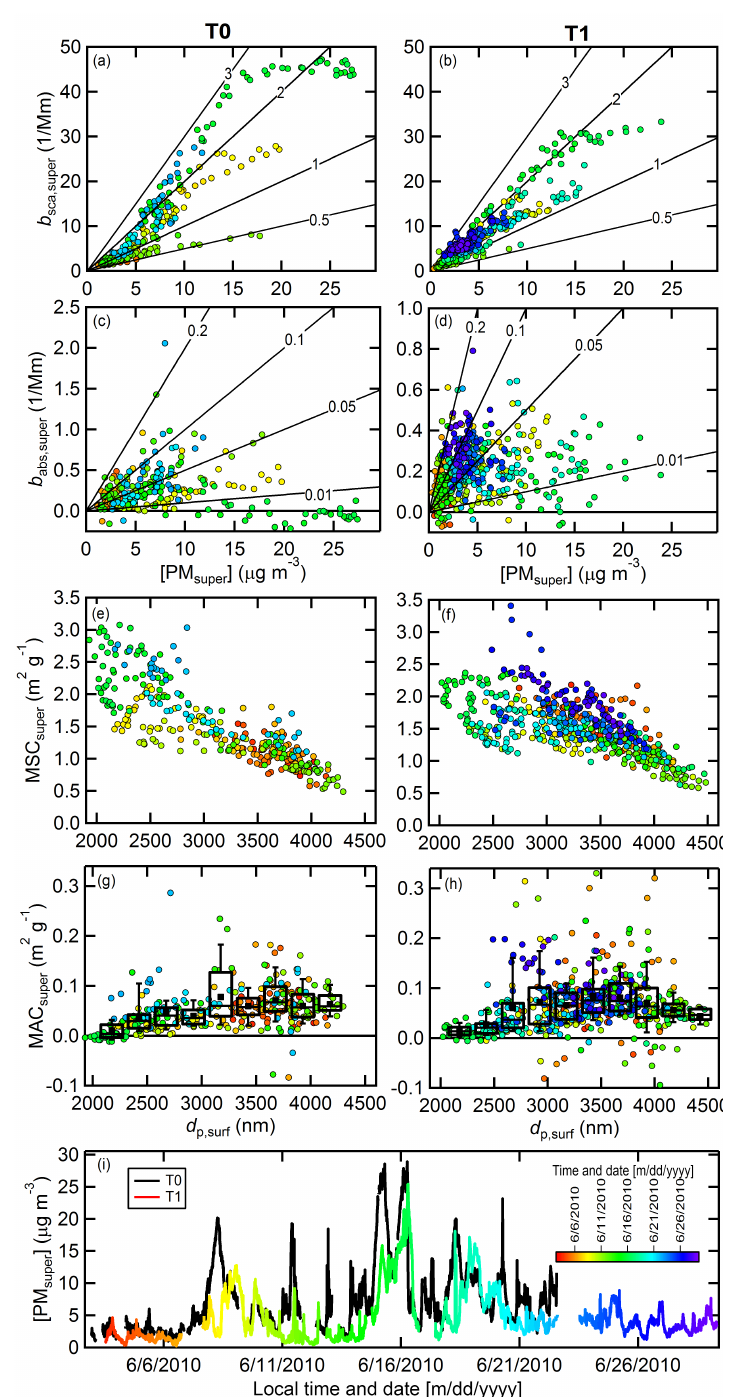
Figure 7. (a, b) Scatter plot between b sca,super at 532nm and [PM super ] for (left panels) T0 and (right panels) T1. The lines correspond to different MSC values (in m 2 g − 1 ). (c, d) Scatter plot between b abs,super at 532nm and [PM super ]. The lines correspond to different MAC values (in m 2 g − 1 ). (e, f) The relationship between 1h average MSC values and the surface-area-weighted mean diameter, d p,surf at the two sites. (g, h) The relationship between 1h average MAC values and d p,surf at the two sites. The individual 1h average data points are shown overlaid by box-and-whisker plots showing the mean (), median (–), lower and upper quartile (boxes), and 9th and 91st percentile (whiskers). The points in (a) – (h) are colored according to time, and correspond to the colors in the bottom figure and color scale. (i) Time series of the supermicron particle mass concentration for T0 and T1. T0 values are black lines, and T1 values are colored according to